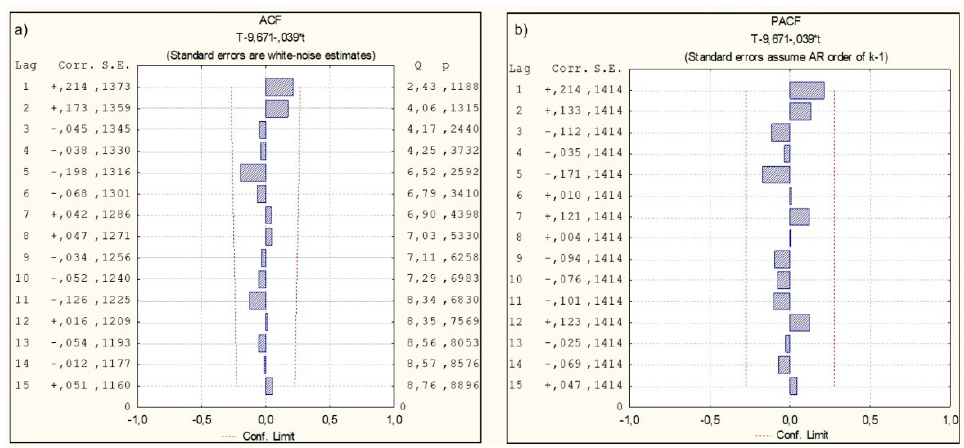
Figure 8. ACF ( a ) and PACF ( b ) for mean annual water temperature for station Oder-Brzeg with the excluded trend (Cols: Lag, Correlation, Standard Error, Q and P–parameters).